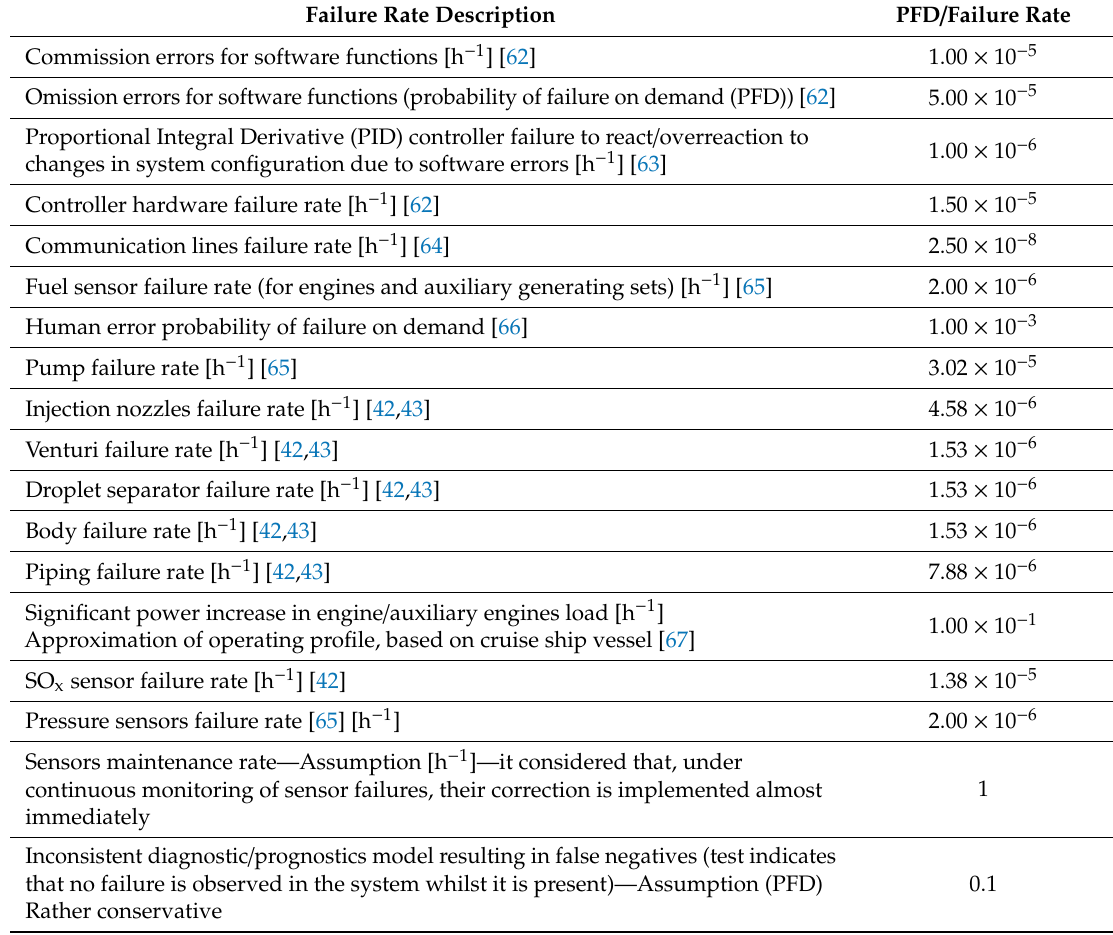
Table 4. Data used as